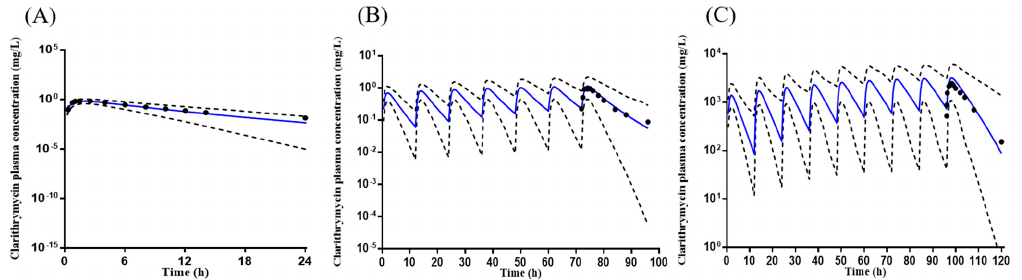
Figure 1. The mean observed (black dot) and predicted (solid blue line, n = 100) plasma clarithromycin concentration–time profiles. ( A ) After administration of a single 250 mg oral dose, observed n = 17 [20]; ( B ) After administration of multiple (7) doses (250 mg, every 12 h), observed n = 17 [20]. ( C ) After administration of amoxicillin 1000 mg/clarithromycin 500 mg for 5 days, observed n = 20 [11]. The black dotted lines represent the 5th and 95th percentiles. The observed data were adapted from references [11,20].